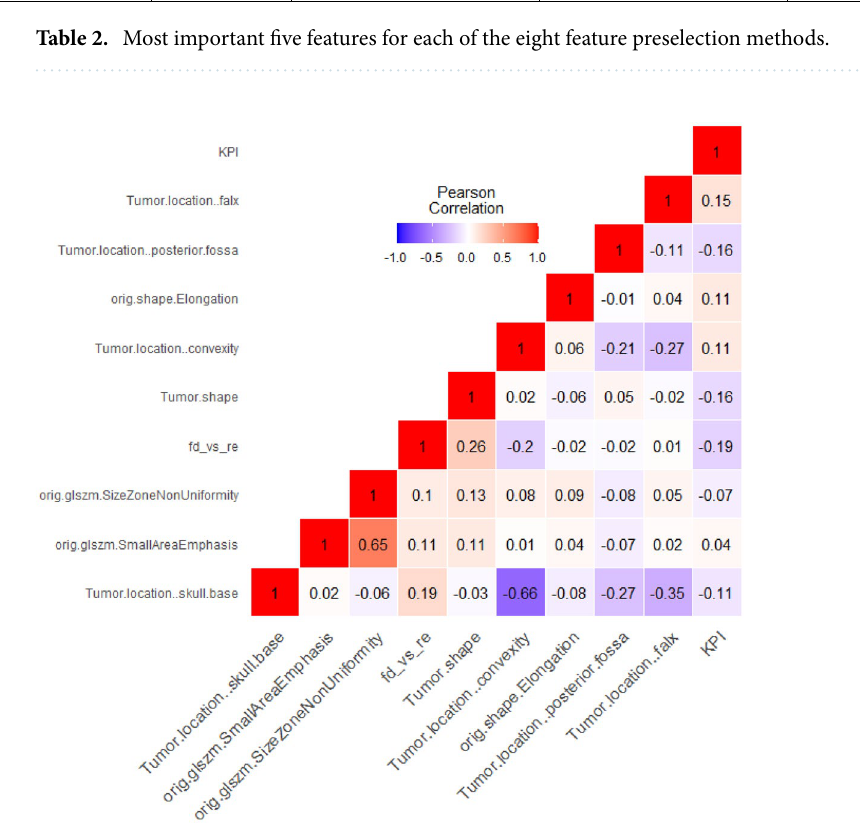
Figure 3. Pearson correlation matrix for the 10 most frequently selected